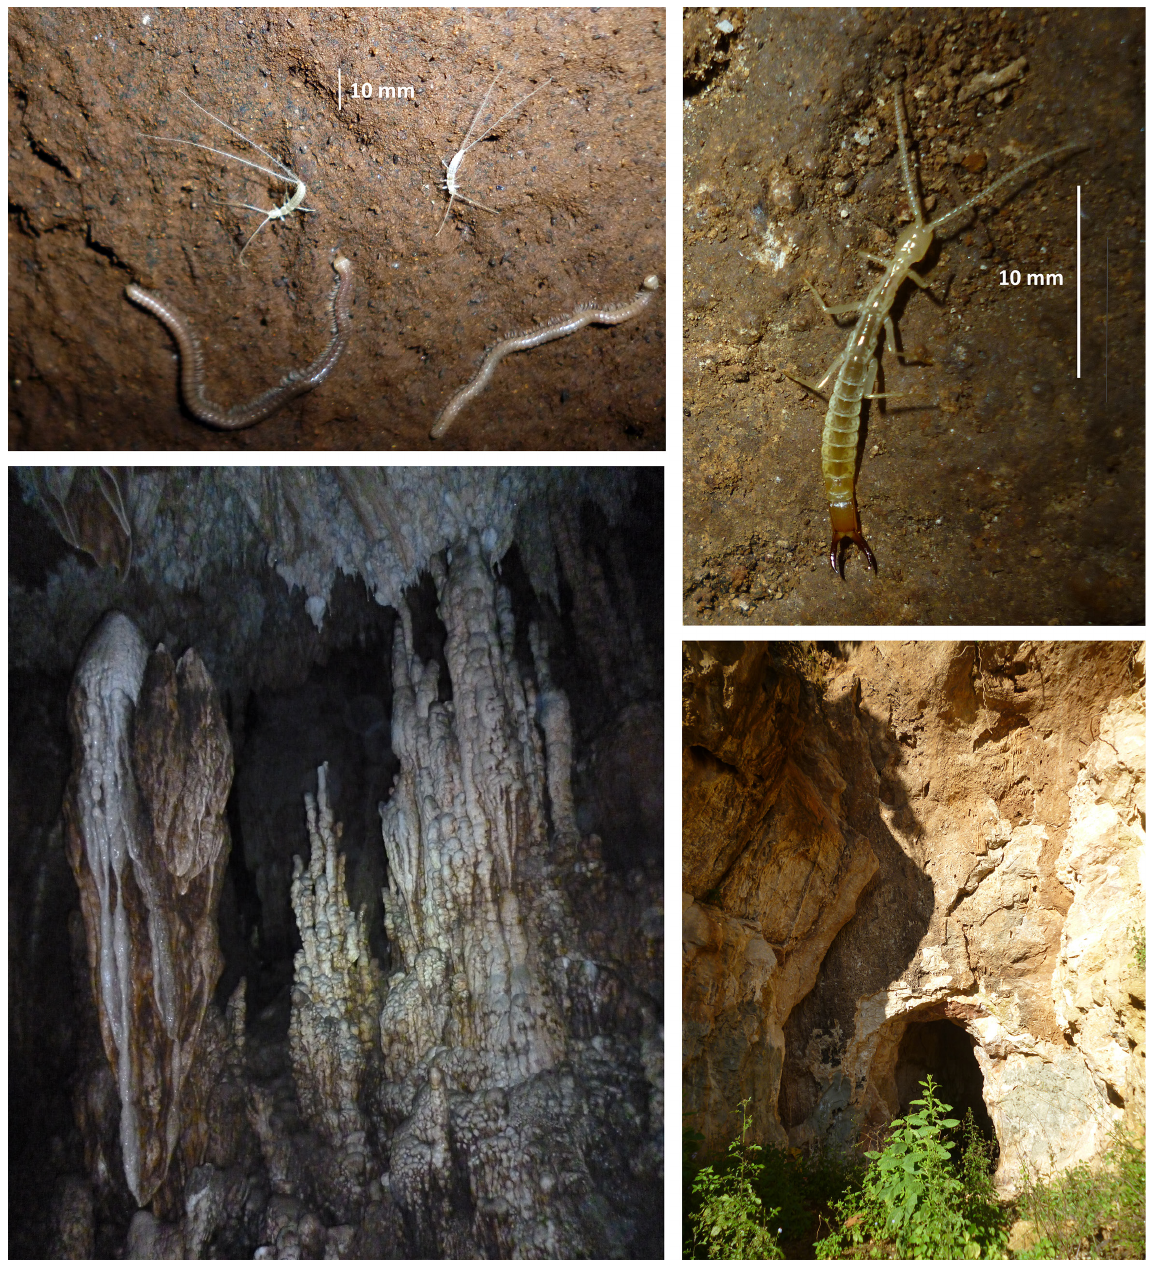
Figs 1‒4. Cave-adapted diplurans from Win Tin Twin Cave, Ywangan karst, Shan State,